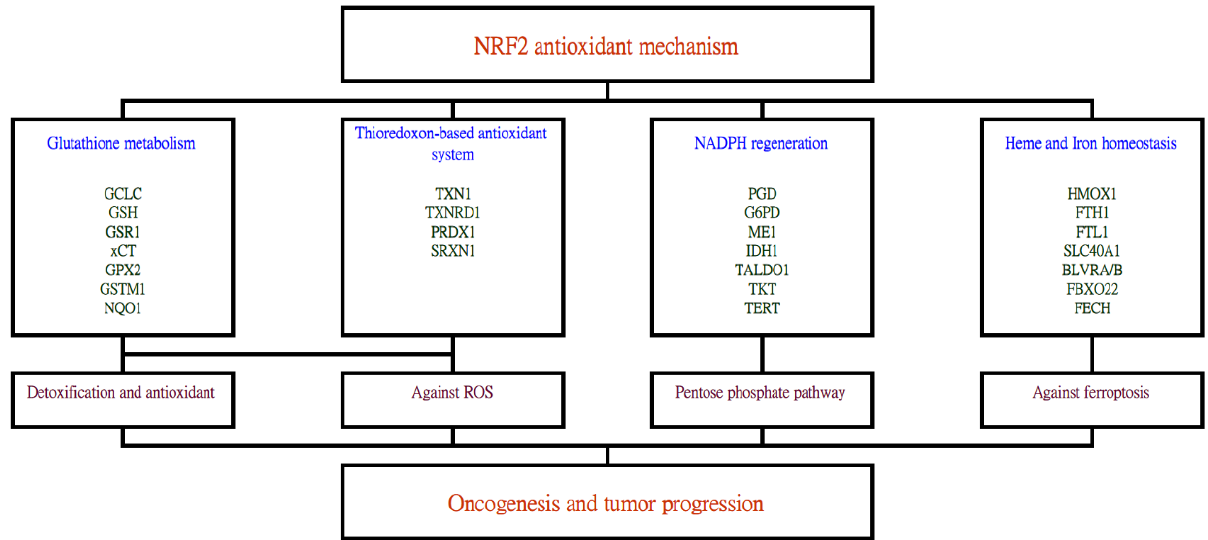
Figure 1. The stress-induced NRF2 antioxidant system can activate a series of downstream genes which ultimately leads toward lung cancer carcinogenesis and progression. Genes activated by the NRF2 transcription factor include those related to glutathione metabolism, thioredoxin-based antioxidant system, NADPH regeneration and heme and iron homeostasis. Subsequent effects, such as detoxification, reactive oxygen species removal, pentose phosphate pathway and inhibition of ferroptosis then follow.